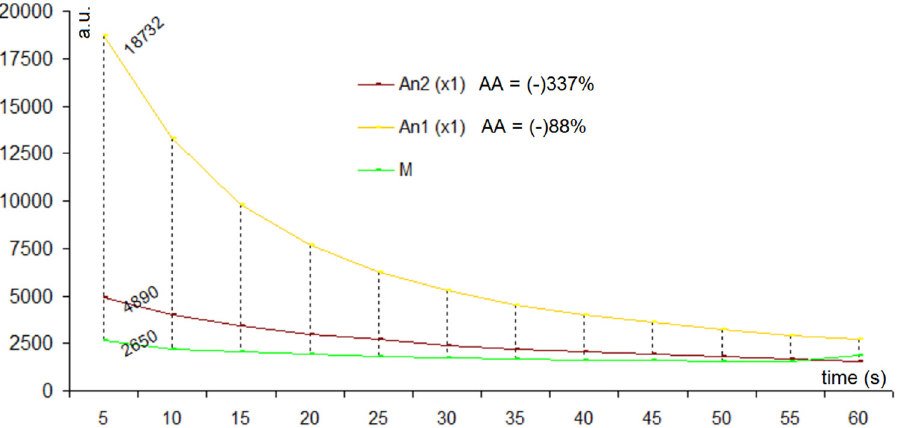
Figure 3: Antioxidant activity assay on the A. nemorosa L. polar extracts ( An1, An2, dilution series × 1 ) , in comparison with the control sample ( M, dilution series × 1 ) ; n = 3.